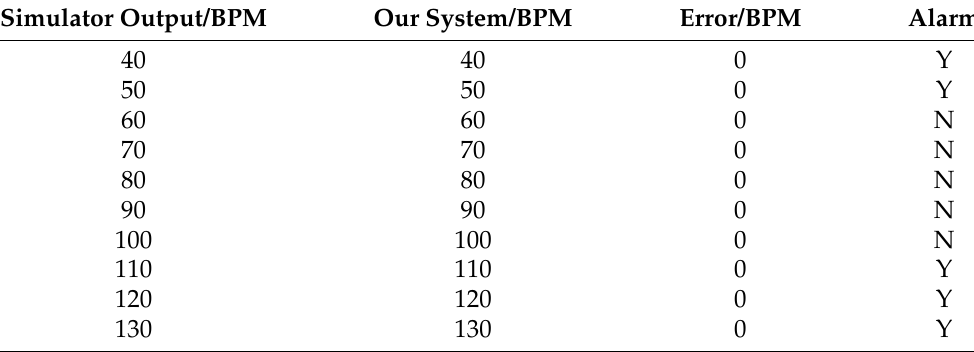
Table 3. ECG signal simulator test